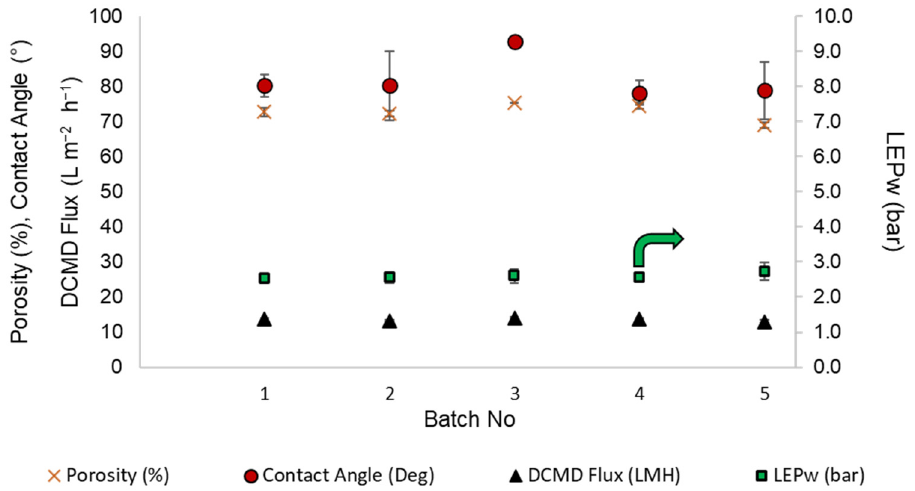
Figure 4. Porosity (%), contact angle (°), DCMD flux (L m − 2 h − 1 ), and liquid entry pressure (LEP w , bar) of different batches of 1.5 kg size.